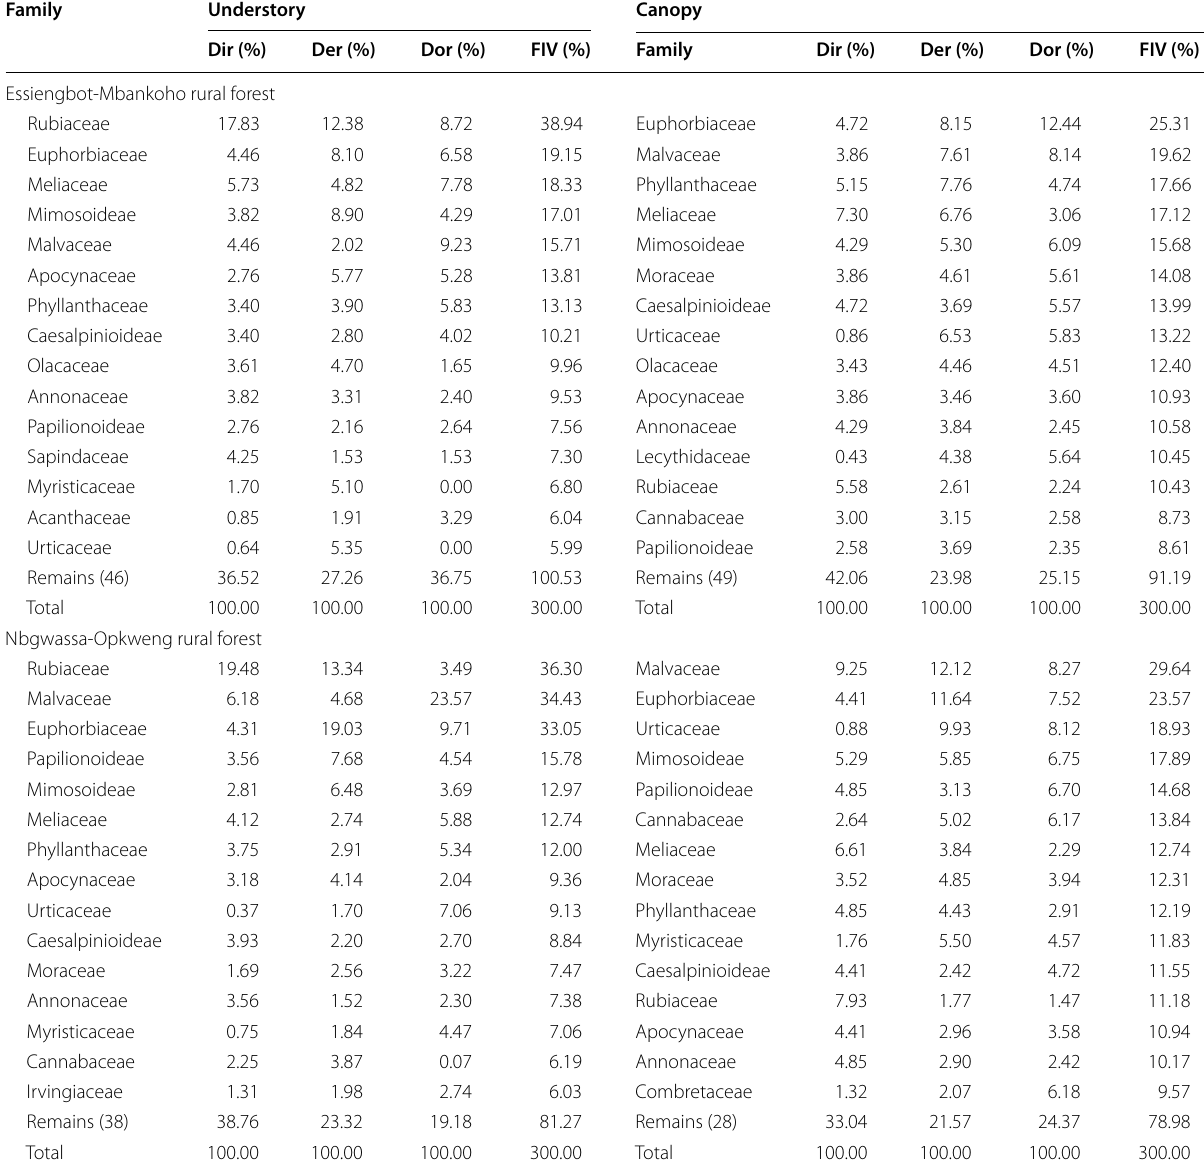
Table 2 The 15 most important families (sub‑families) in the understory and canopy in each rural forest according to decreasing order of family importance